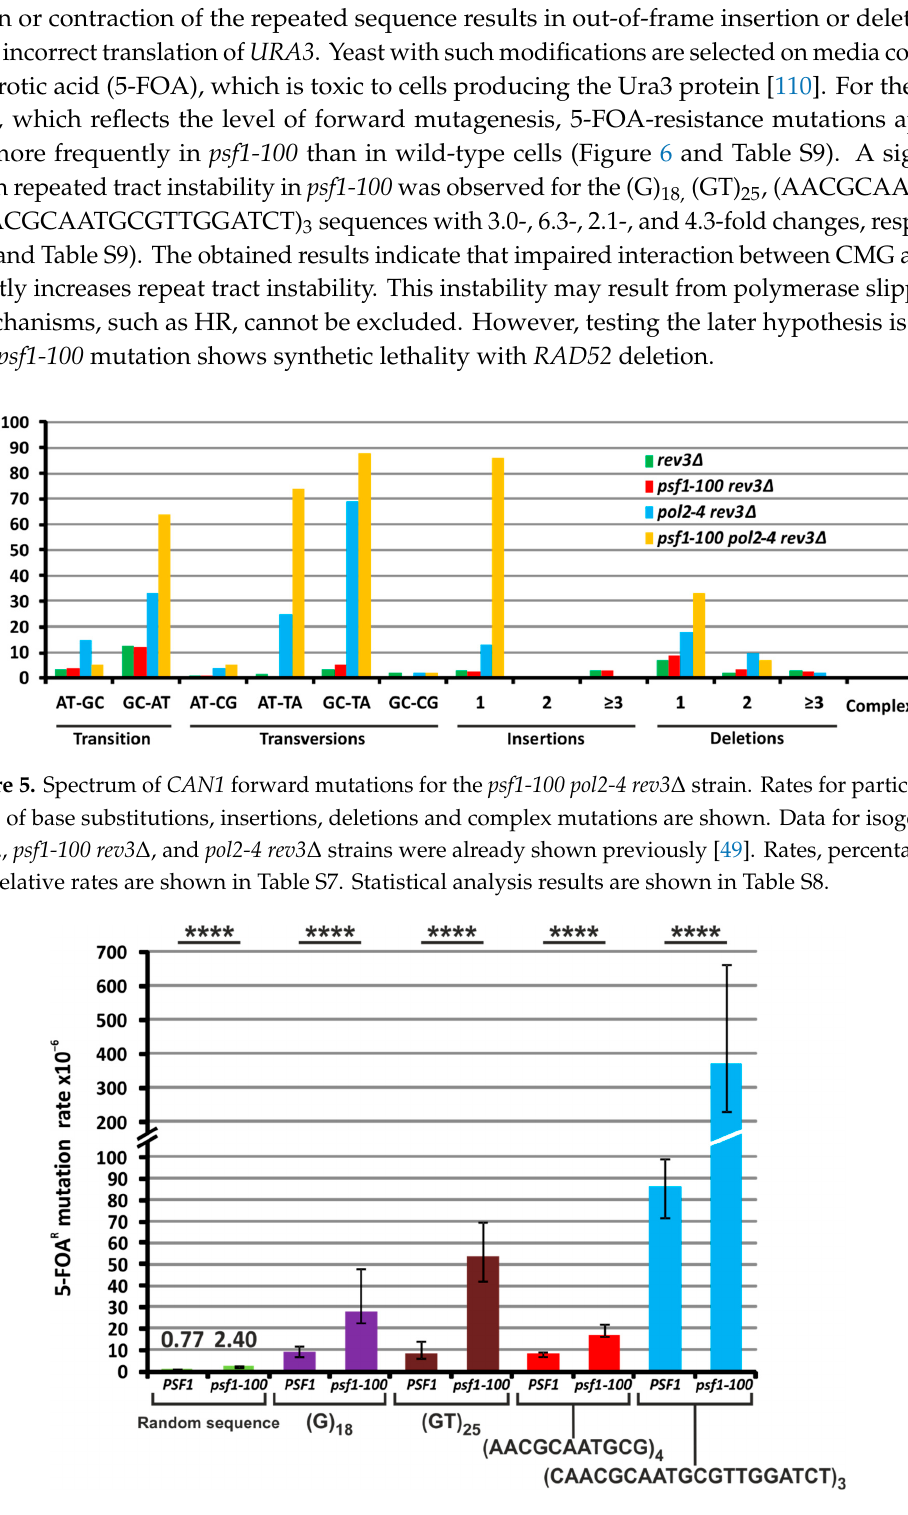
Figure 6. The psf1-100 allele enhances the instability of various repeat tracts. The 5-fluoroorotic acid (5-FOA)-resistance mutation rates were determined for wild-type and psf1-100 cells carrying plasmids with the indicated repetitive sequences. Median values with 95% confidence intervals were calculated from data obtained for at least twenty cultures of each strain. The p- values for psf1-100 versus the respective wild-type strains, calculated using the nonparametric Mann-Whitney U statistical test, were ≤ 0.0001 (****). All associated data are shown in Table S9.